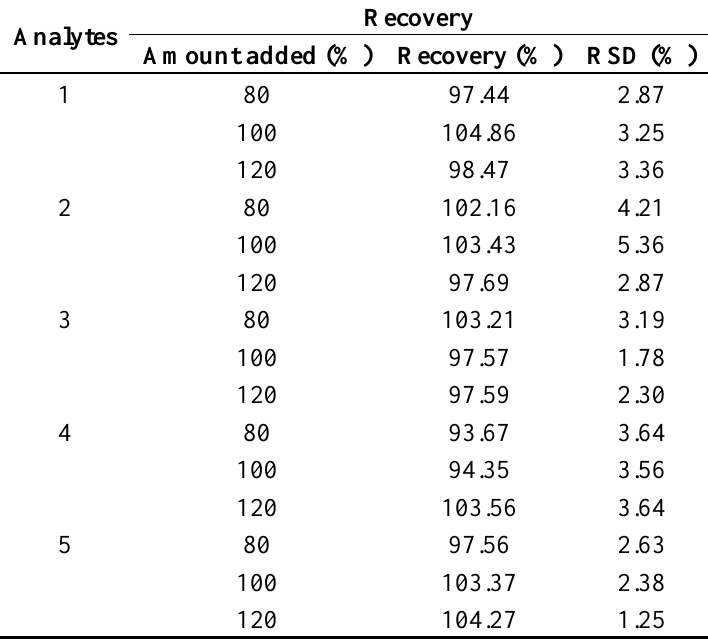
Table 3. Recovery of the terpene lactones and flavonol aglycones in the G. biloba